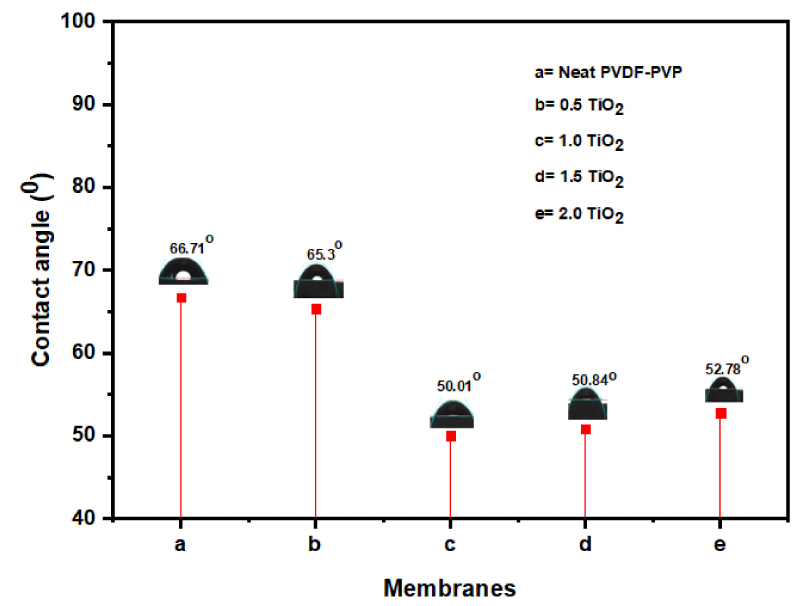
Figure 3. Membrane contact angle at various TiO 2 loading: ( a ) neat TiO 2 , ( b ) 0.5 wt% TiO 2 , ( c ) 1.0 wt% TiO 2 , ( d ) 1.5 wt% TiO 2 , and ( e ) 2.0 wt% TiO 2 .